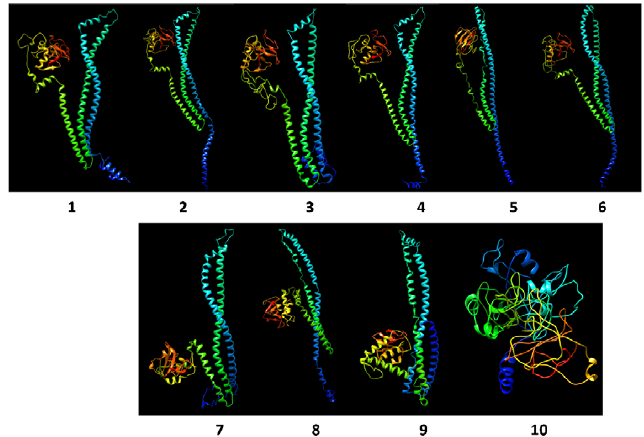
Figure 6. Proteins were modelled using the FASTA sequences available on UniProt or KEGG databases and the annotated genome of strain GCRL163. The upper group (1–6) are for proteins with the CwlO-CHAP domain architecture shown in Figure 4b: 1 = L. casei GCRL 163 genome sequence, uncharacterized protein; 2 = L. casei W56 possible TrsG protein (BN194_00240); 3 = S. mutans SagA protein (Q8DWM3); 4 = S. pyogenes SibA secreted protein (Q1JJ91); 5 = L. rhamnosus p40 surface antigen (LGG_00031); 6 = L. rhamnosus multi-species CHAP-domain containing protein WP_064517214.1.